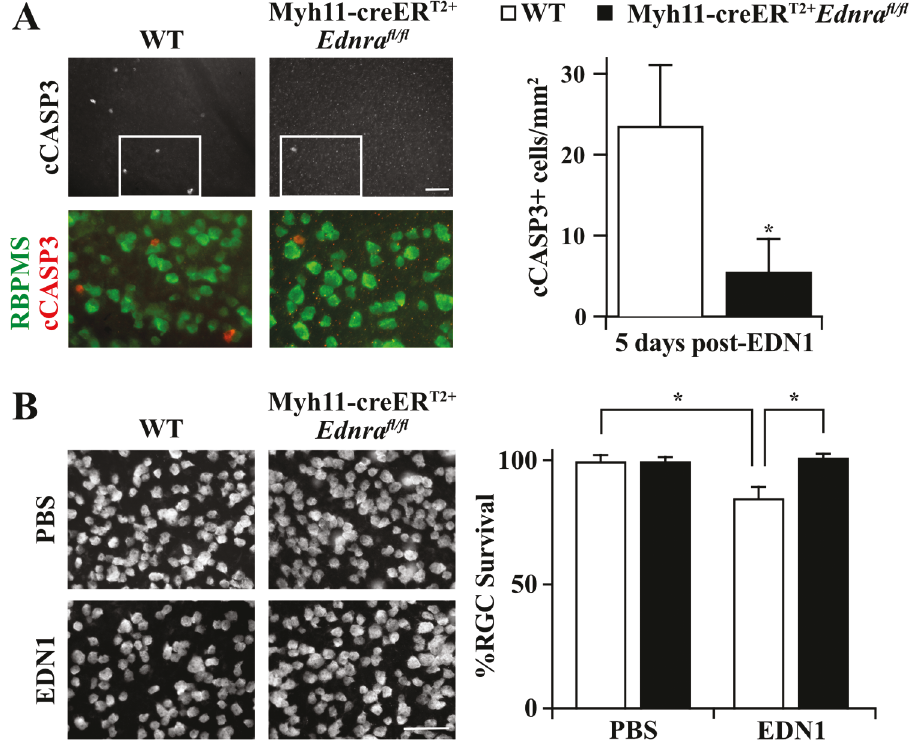
Fig. 5 EDNRA expressed by vascular mural cells elicited RGC death in response to EDN1. A Flat mounted retinas immunoassayed for cCASP3 and RBPMS 5 days post-EDN1 injection. Ednra deletion from vascular mural cells signi fi cantly reduced numbers of cCASP3 + RGCs after EDN1 injury. cCASP3 + RGCs/mm 2 : WT: 23.6 ± 7.6, Myh11-creER T2 + Ednra fl / fl : 6.0 ± 4.4 ( n ≥ 9, * P = 0.009, Mann – Whitney test). B Flat mounted WT and Myh11-creER T2 + Ednra fl / fl retinas immunoassayed for RBPMS 28 days post-EDN1 injection. Mural cell deletion of Ednra prevented